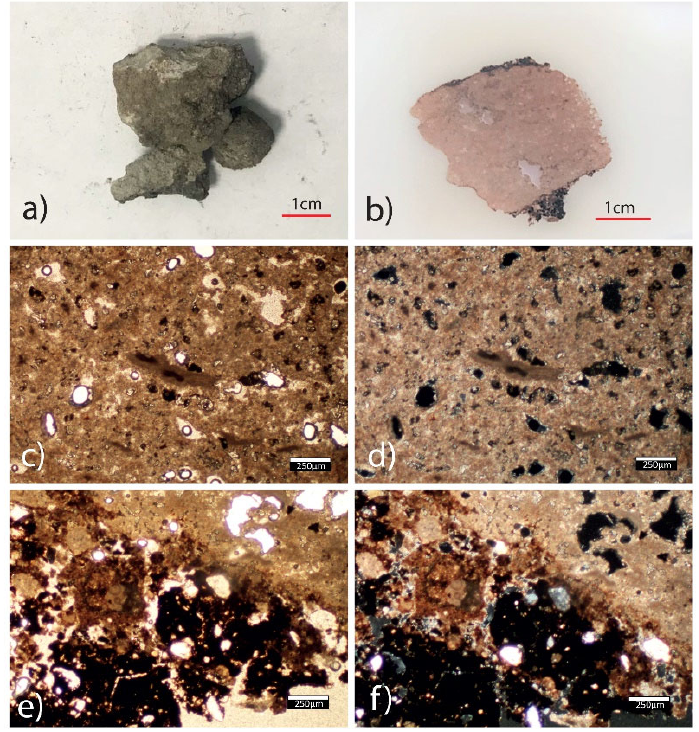
Figure 11. Sample MIN10 (Groups P4b) microphotographs under polarised light microscope (PL ‐ OM). Limestone samples with dark residue of cocciopesto mortar. ( a ) analysed fragment; ( b ) thin section; ( c ) parallel polars and ( d ) crossed polars: microcrystalline calcitic matrix; ( e ) parallel polars and ( f ) crossed polars: contact between the limestone fragment and dark cocciopesto mortar.